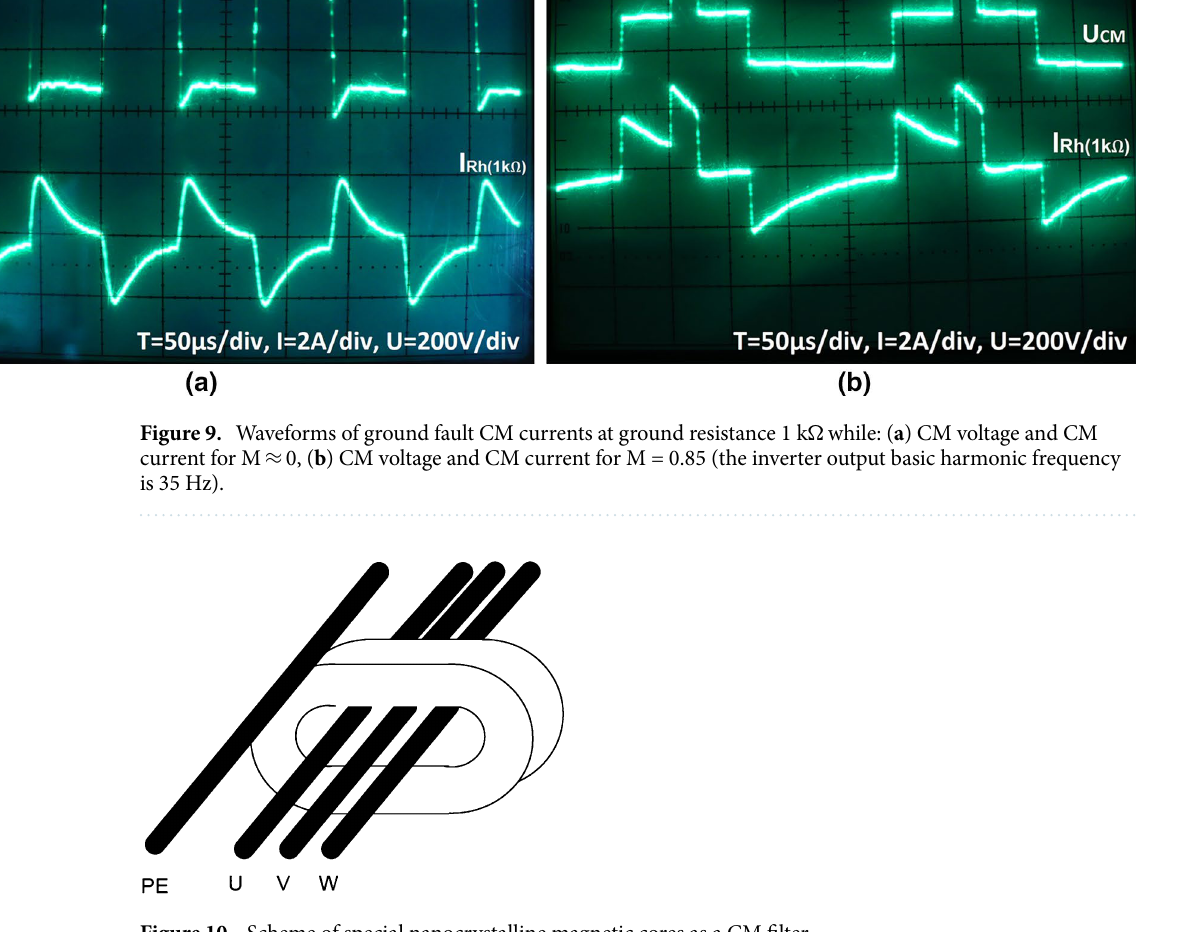
Figure 10. Scheme of special nanocrystalline magnetic cores as a CM filter.